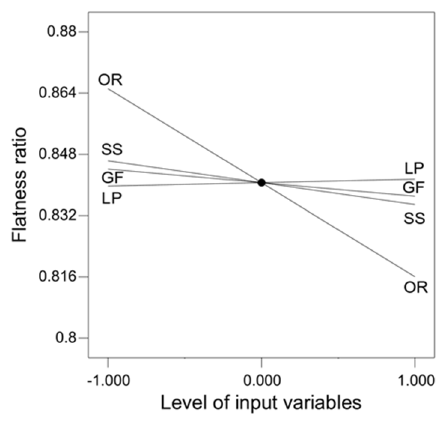
Figure 7. The influence of different processing parameters on the flatness ratio.